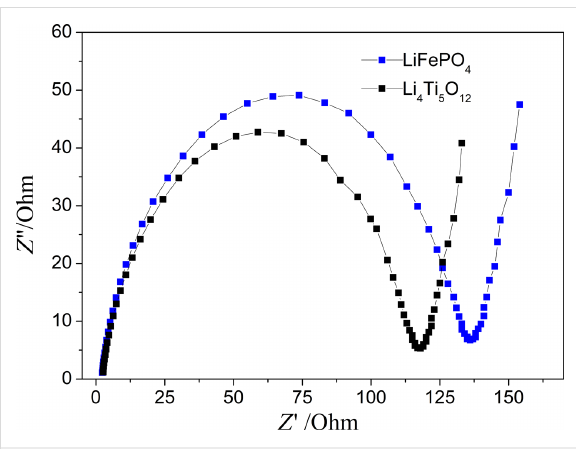
Figure 9: EIS curves of LiFePO 4 and Li 4 Ti 5 O 12 fiber membrane elec-